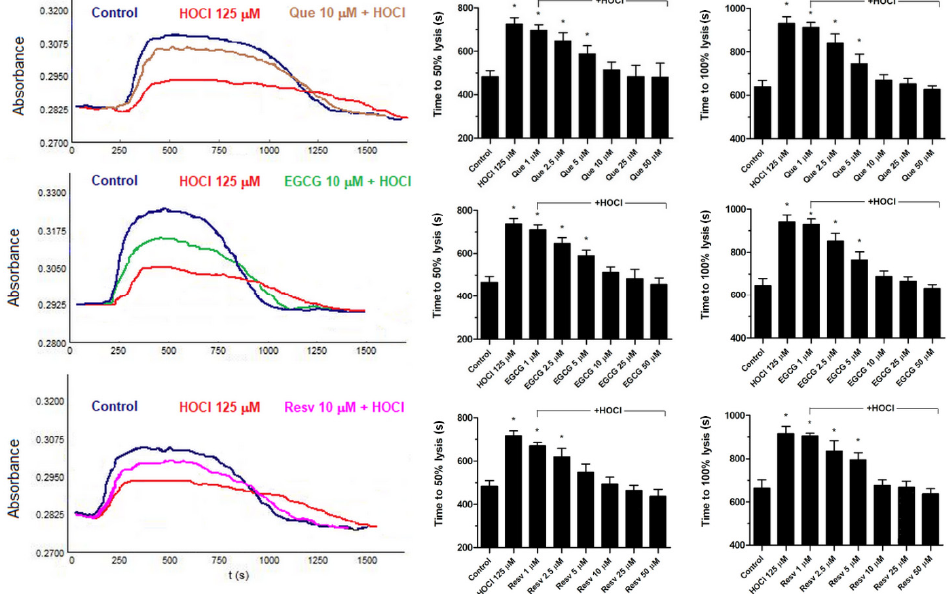
Figure 4. Effects of quercetin, epigallocatechin gallate, and resveratrol on HOCl-evoked attenuation of fibrinolysis. Plasma samples were incubated with appropriate vehiculum (ethanol or water) or with HOCl (125 μ M for 5 min) or with indicated concentrations of Que, EGCG, or Resv, added 1 min before HOCl . Coagulation was triggered by the addition of CaCl 2 (to 20 mM final concentration). The time to 50% and 100% of lysis was determined as the time required for a decrease in absorbance (of 50% or 100%, respectively) after reaching the maximal turbidity, measured in the presence of tissue plasminogen activator (200 ng/mL final concentration). Representative lysis profiles from six experiments are presented. * p < 0.05 vs. control.